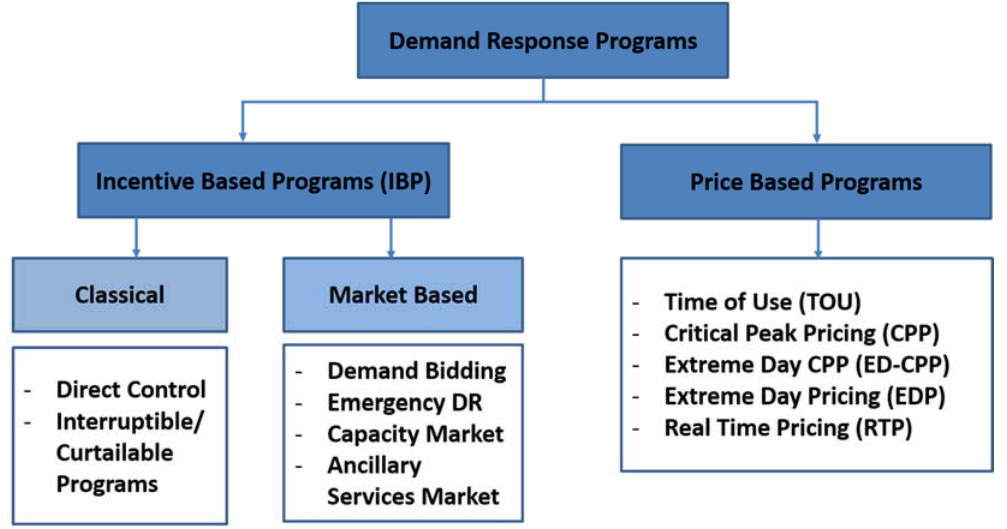
Figure 2. Classification of Demand Response Programs.